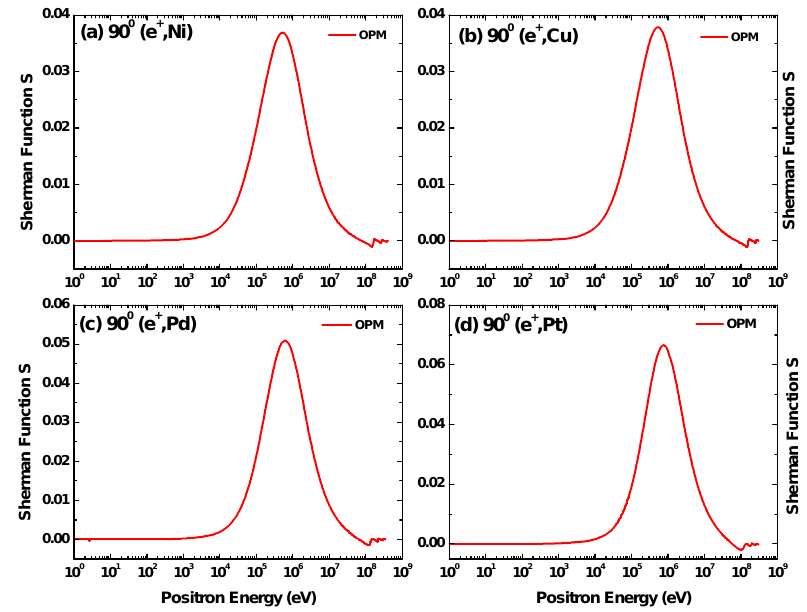
Figure 25. Energy-dependent Sherman function S for positron scattering from ( a ) Ni 58 , ( b ) Cu 63 , ( c ) Pd 108 , and ( d ) Pt 196 at a scattering angle θ = 90 ◦